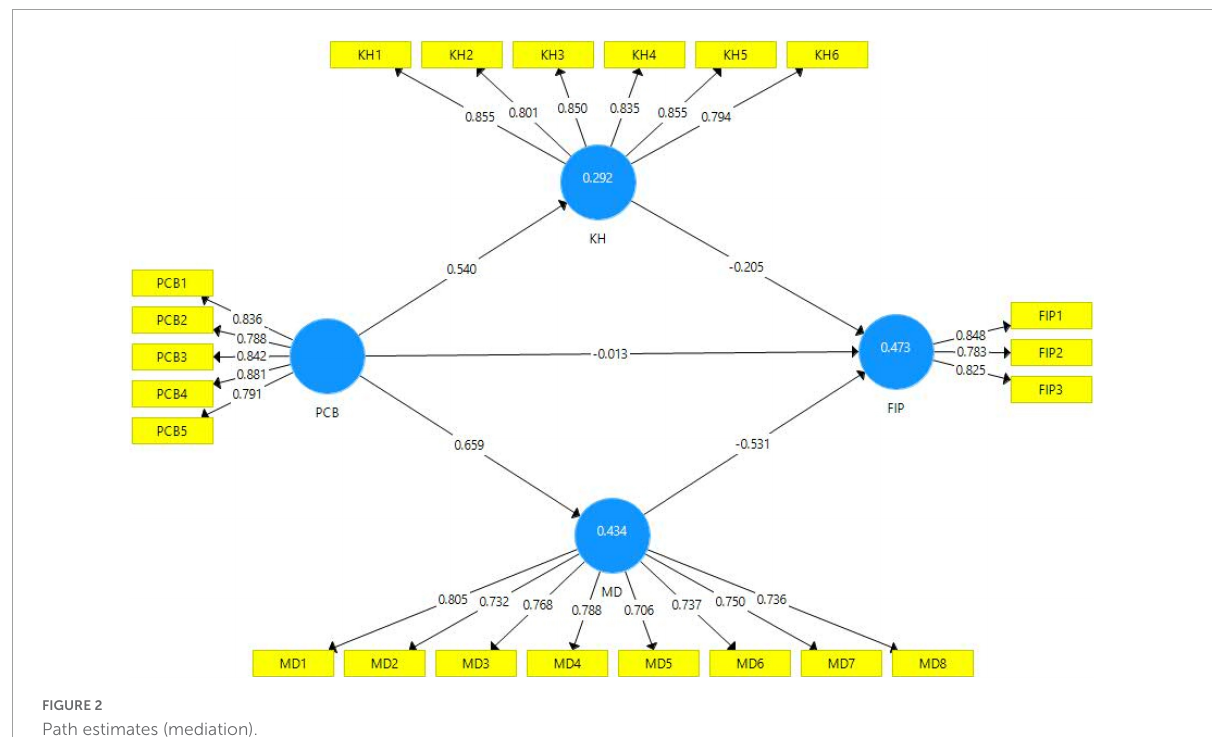
FIGURE2 Path estimates (mediation).